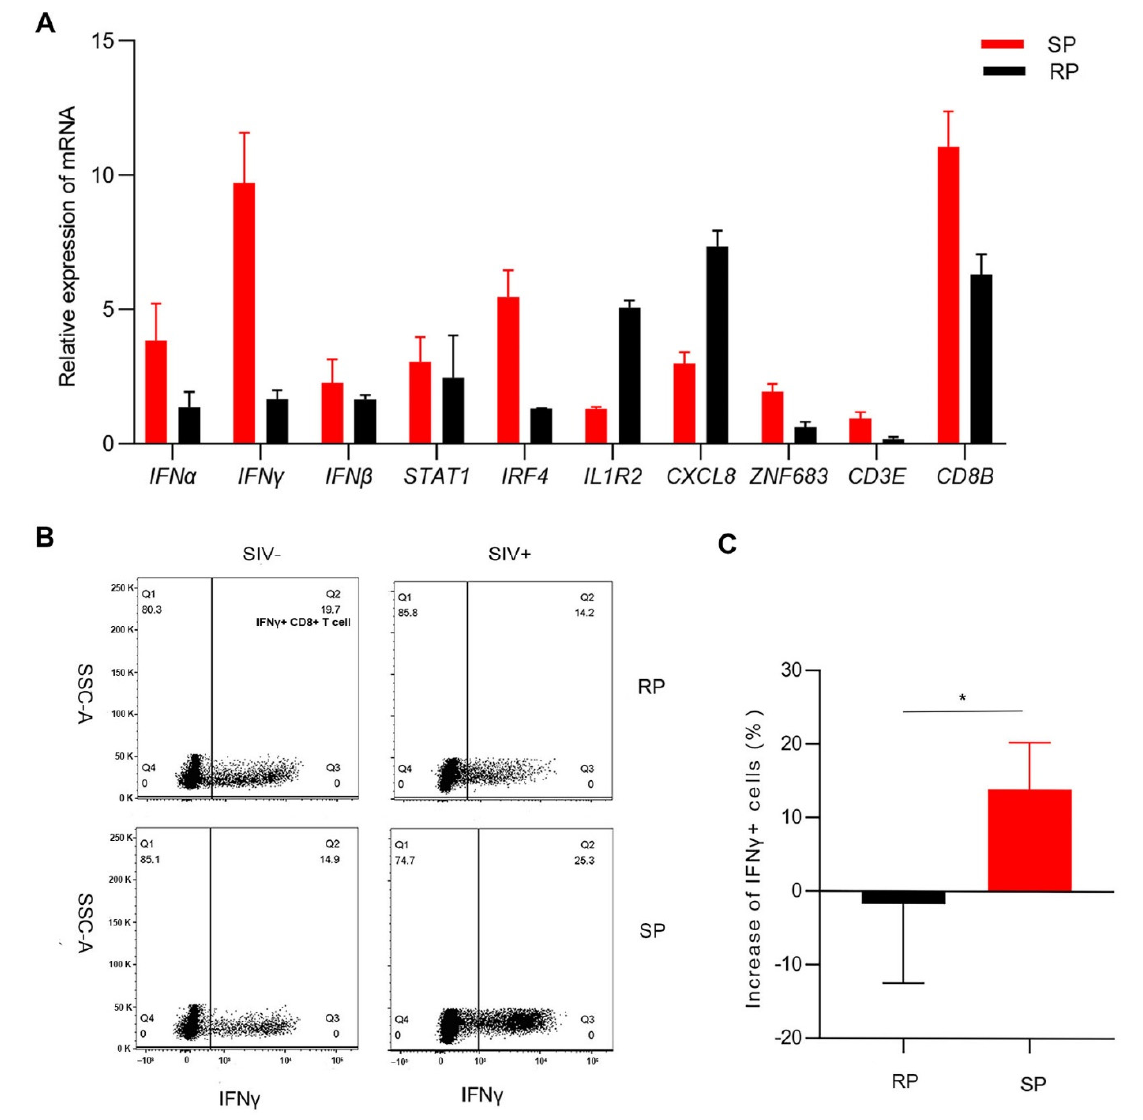
Figure 4. Confirmation of the expression of several DEGs. ( A ) Determination of DEGs expression by real-time PCR in the lungs. Changes ( B ) and quantitative analysis ( C ) of IFN γ + CD8+ T cells after infection in PBMCs. The Q2 gate represents IFN γ + CD8+ T cells. The bars and error bars indicate the means ± SEMs. Paired t tests were used to compare groups. * p < 0.05. RP: n = 3; SP: n = 3; SIV-: n = 4.